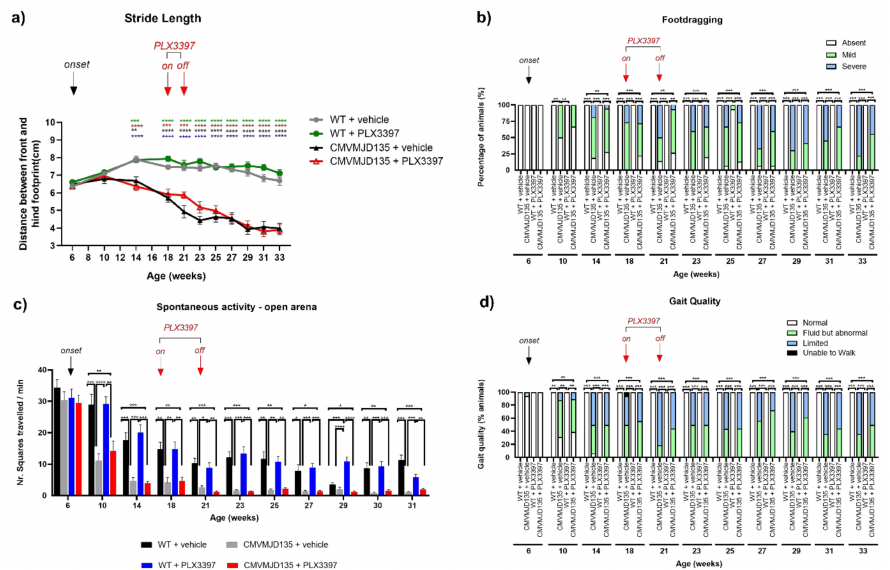
Figure 7. Abnormal stride length and footdragging phenotype observed in CMVMJD135 animals is not affected by PLX3397 treatment. ( a ) The treatment with PLX3397 had no impact on the gait quality of CMVMJD135 mice, which displayed an abnormal stride length when compared with WT mice. + vehicle; * WT + vehicle and CMVMJD135 + PLX3397; * WT + PLX3397 and CMVMJD135 + vehicle; and * WT + PLX3397 and CMVMJD135 + PLX3397. One-way ANOVA (post hoc Tukey’s test). ( b ) PLX3397 treatment had no impact on the severity of the footdragging phenotype that is